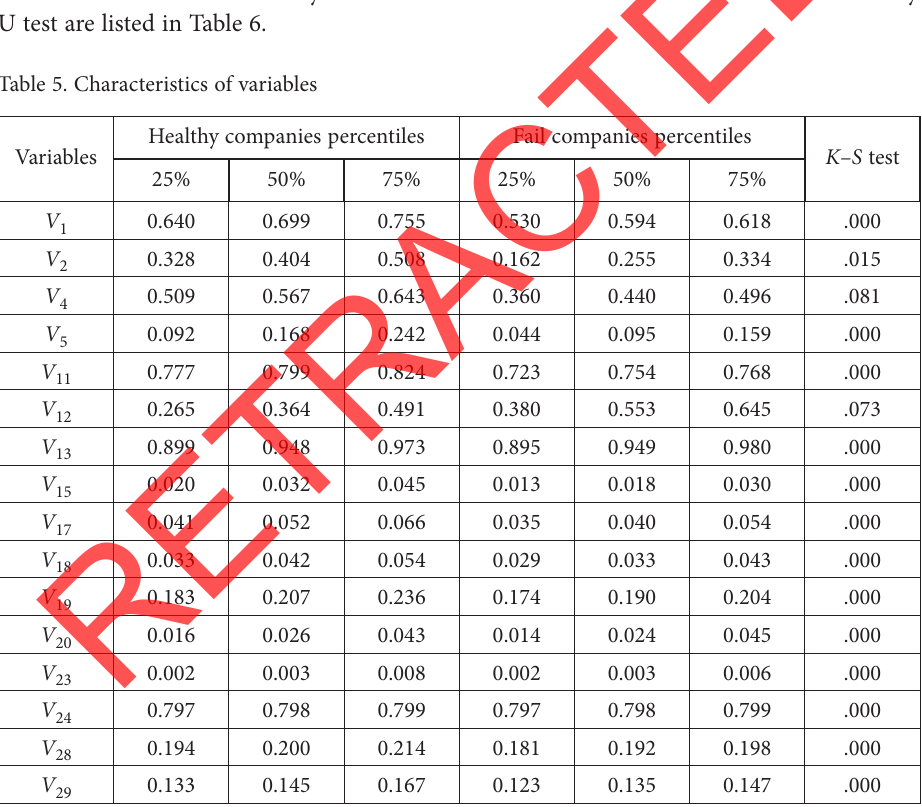
Table 5. Characteristics of